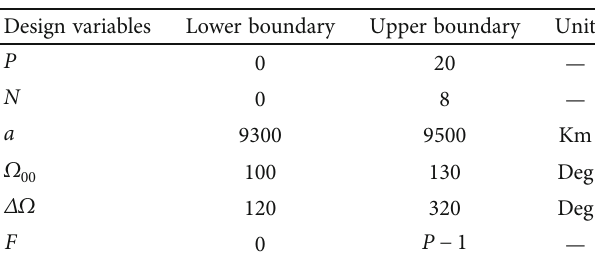
Figure 4: Coverage polygons for the 108 key cities, a = 9450 km, inc = 74 ° . Table 3: Constraints on the design